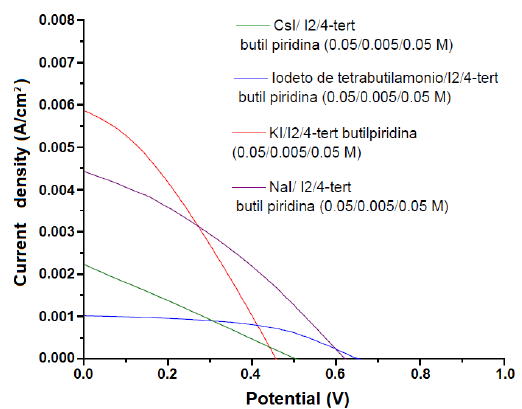
Figure 13. j x V curve for cells screening counter-ions to iodide in less concentrated electrolyte solutions. Other conditions: Substrate: FTO; counter electrode: graphite paste; Photoanode: TiO